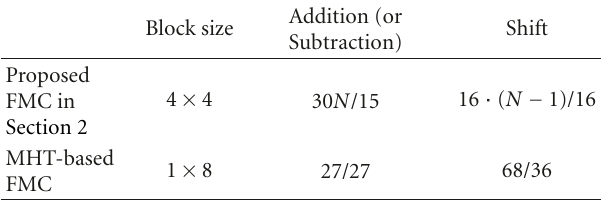
Table 2: Complexity comparison (FMC